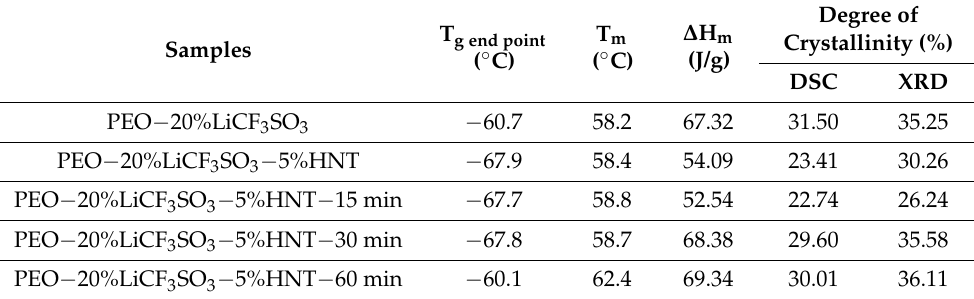
Figure 7. DSC curves of PEO − 20%LiCF 3 SO 3 and PEO − 20%LiCF 3 SO 3 − 5%HNT with and without ul- trasonication. Table 1. T g , T m , ∆ H m , and degree of crystallinity of SPE samples.